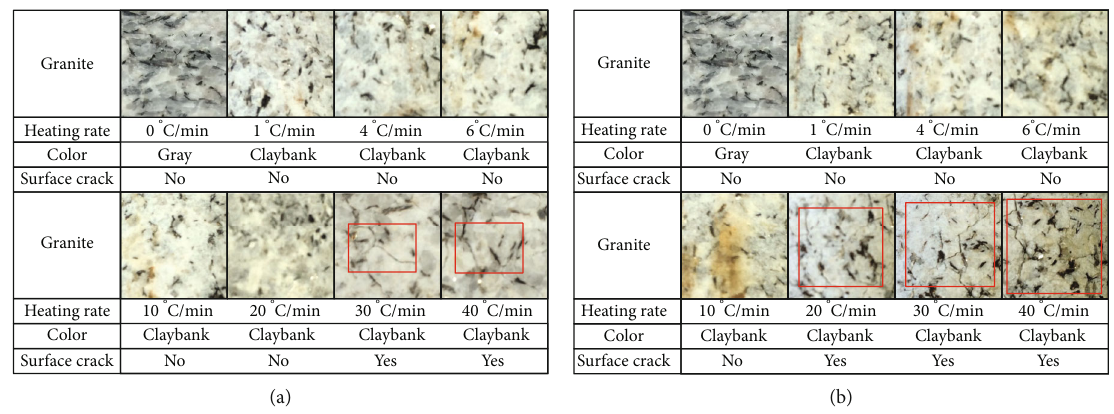
Figure 5: The surface appearances of thermal shock treated granite specimens (a) T = 400 ° C and (b) T = 600 ° C